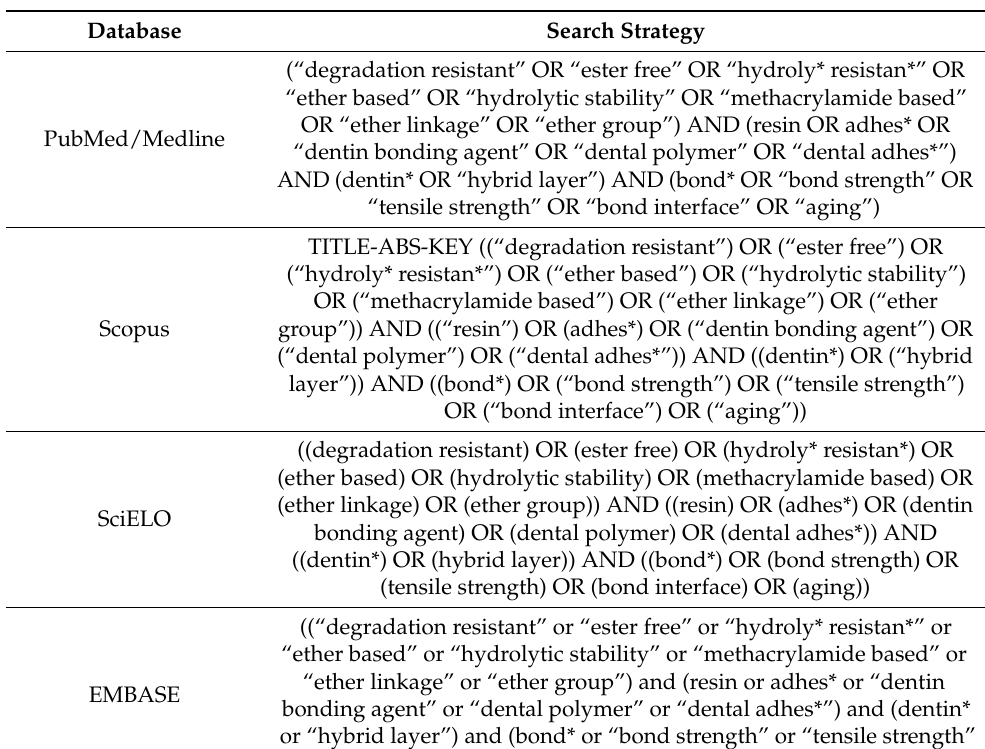
Table 1. Search strategy used in each database to retrieve full-text